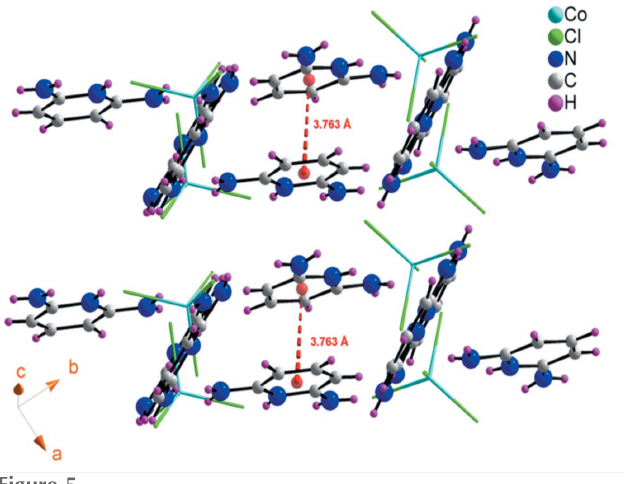
Figure 6 View of the Hirshfeld surface of (I) mapped over d norm .